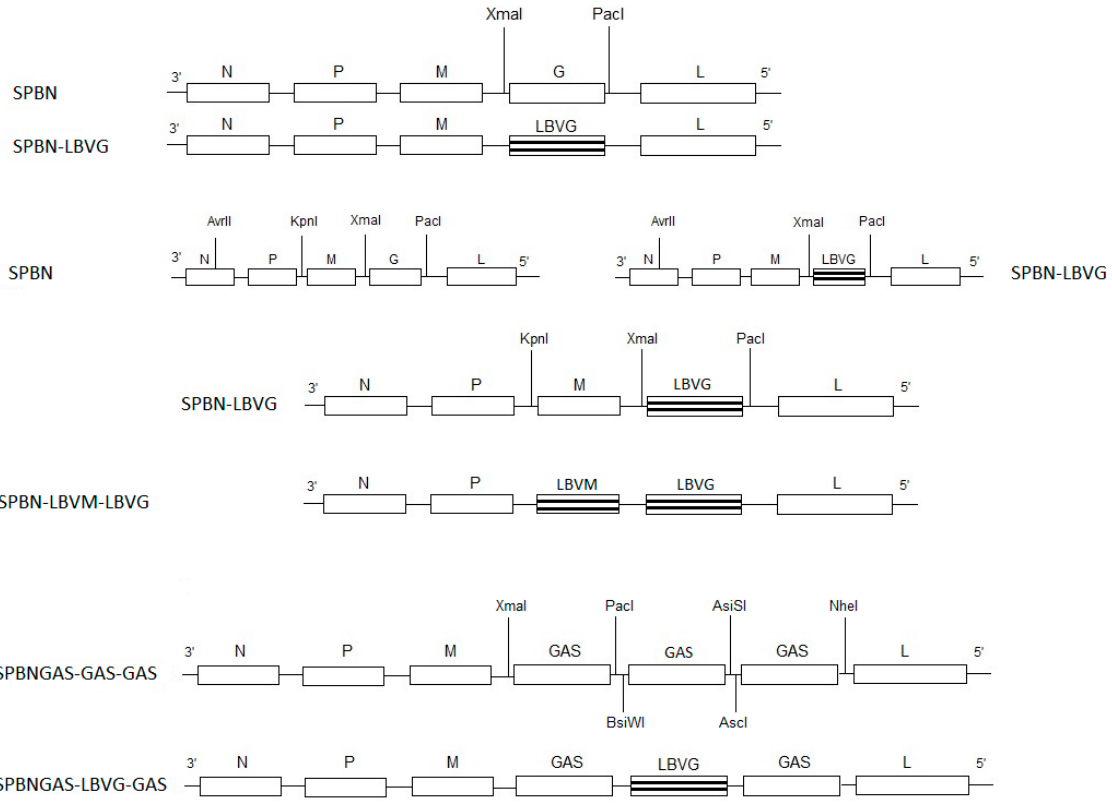
Figure 1. Schematic representation of the construction of recombinant viruses. Restriction enzyme sites are indicated ( XmaI , PacI , AvrII , KpnI . BsiWI , AsiSI , NheI and AscI ). GAS represents the SPBN G gene with two amino acid substitutions (Asn 194 to Ser and Arg 333 to Glu). The following abbreviations were used: N, nucleoprotein; M, matrix protein; G, glycoprotein; L, RNA-dependent RNA polymerase. LBVM and LBVG represent the LBV M and G gene respectively.